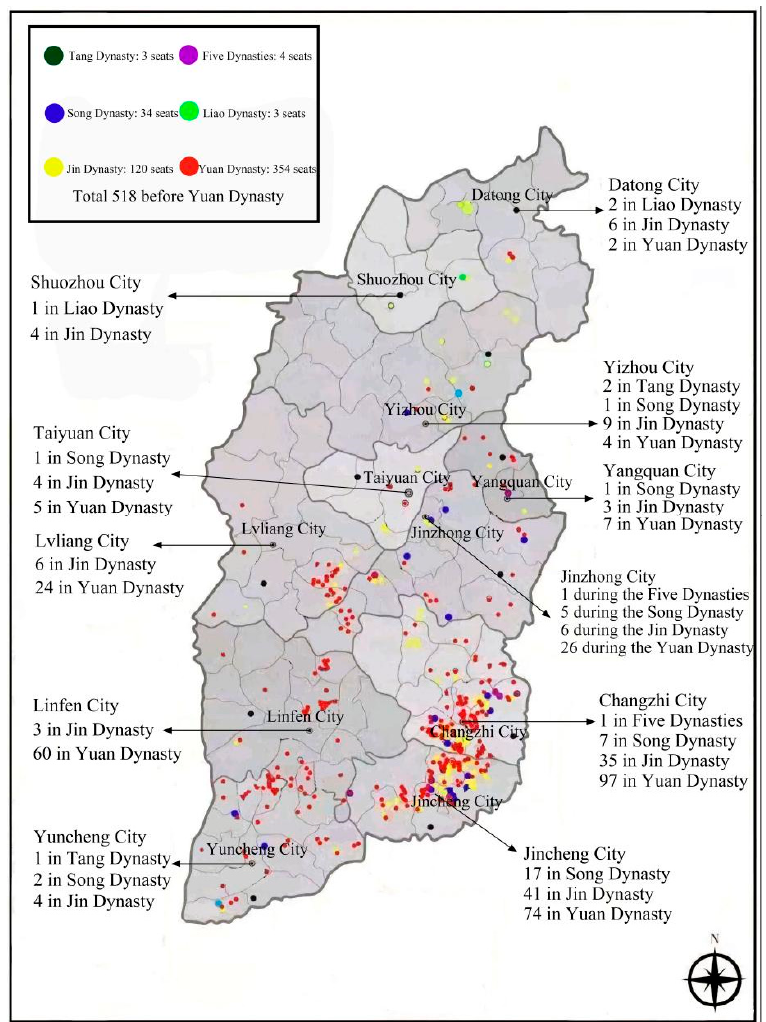
Figure 2. Distribution of ancient wooden buildings in Shanxi Province.